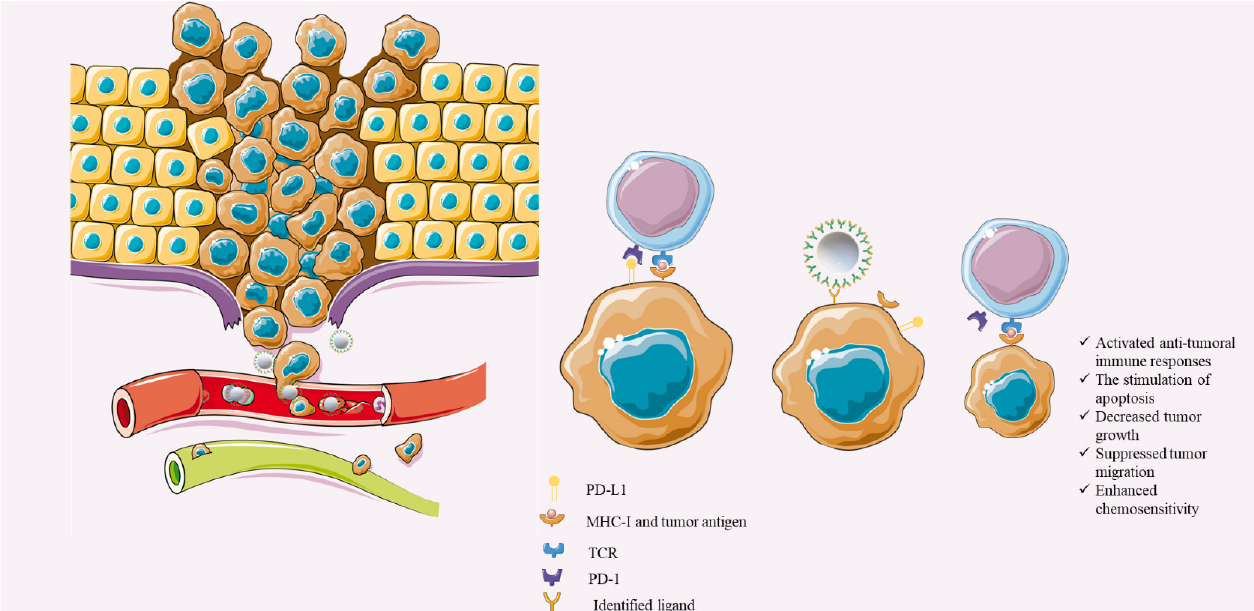
Figure 3. Single-cell sequencing-guided biomimetic-based miR-delivery. After identifying the tumoral antigen based on single-cell sequencing data and fabricating related receptor/CAR/TCR on the biomimetic carriers, the delivery of the PD- L1-inhibiting miRs can substantially stimulate anti-tumoral immune responses, activate apoptosis of tumoral cells, inhibit tumor proliferation, suppress tumor migration, and enhance the chemosensitivity of tumoral cells to chemotherapeutic agents. Objects are obtained from https://smart.servier.com/ (accessed on 25 July